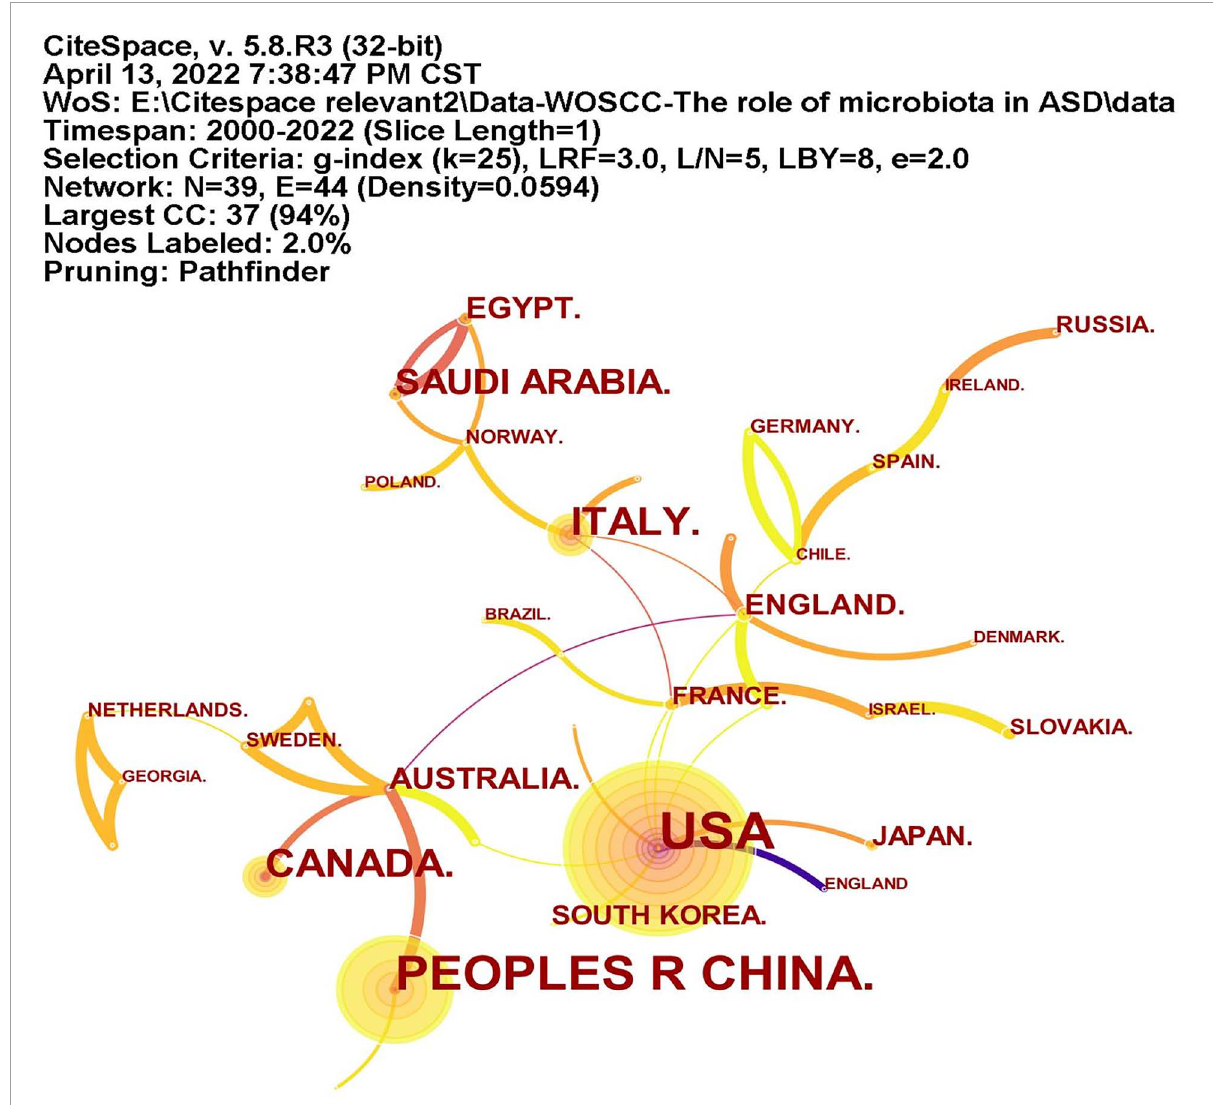
FIGURE3 The network of countries/regions publications and collaborations. The circles represent the number of publications and lines represent collaborations. Larger circles represent more articles published and thicker lines indicate closer